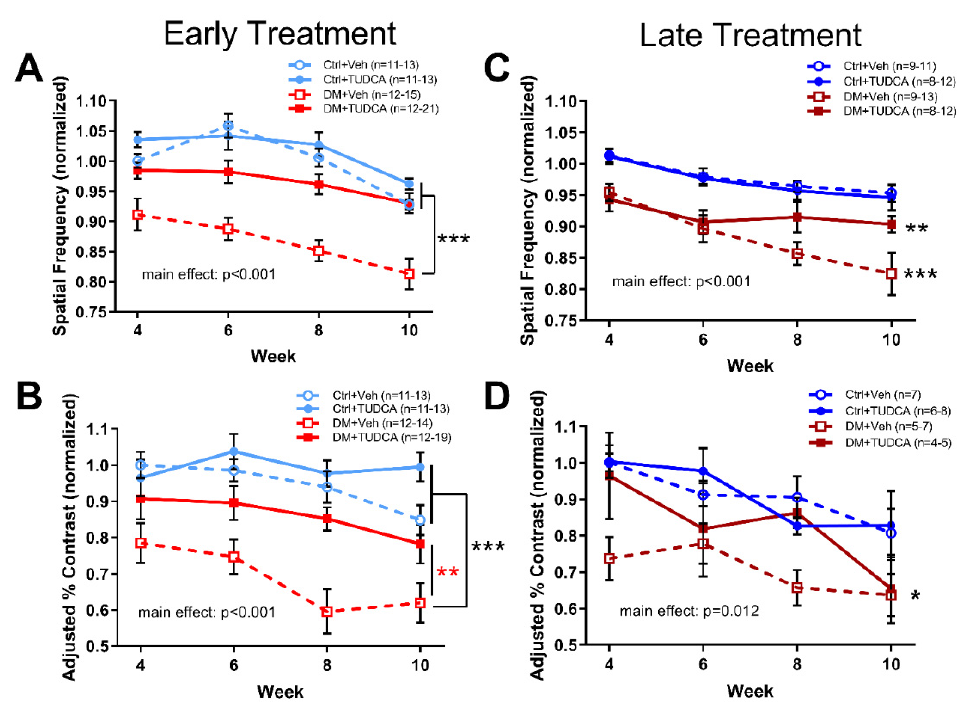
Figure 2. Early TUDCA treatment preserves visual function in diabetic mice. All groups were assessed for spatial frequency and contrast sensitivity thresholds at 4, 6, 8 and 10 weeks following induction of hyperglycemia with values normalized to Ctrl+Veh at 4 weeks. ( A ) In the early treatment experiment, spatial frequency thresholds for Ctrl+Veh, Ctrl+TUDCA, and DM+TUDCA groups were similar, and were significantly higher than those of the DM+Veh group (two-way repeated measures ANOVA, F 3,212 = 37.94, main effect of treatment p < 0.001). ( B ) In the late treatment experiment, spatial frequency thresholds for Ctrl+Veh and Ctrl+TUDCA groups were similar and significantly higher than those of DM+Veh (*** p < 0.001) and DM+TUDCA groups (** p = 0.008) (two-way repeated measures ANOVA, F 3,170 =17.58, main effect of treatment p < 0.001). ( C ) In the early treatment experiment, contrast sensitivity thresholds for Ctrl+Veh and Ctrl+TUDCA groups were similar and both were significantly higher than the DM+Veh group (two- way repeated measures ANOVA, F 3,207 = 16.07, main effect of treatment, p < 0.001). The DM+TUDCA group also significantly differed from DM+Veh (** p = 0.004). ( D ) In the late treatment experiment, contrast sensitivity thresholds for the Ctrl+Veh group were significantly higher than those of the DM+Veh group (* p = 0.026; two-way repeated measures ANOVA, F 3,95 = 4.42, main effect p = 0.012). Holm–Sidak post hoc comparisons indicated by